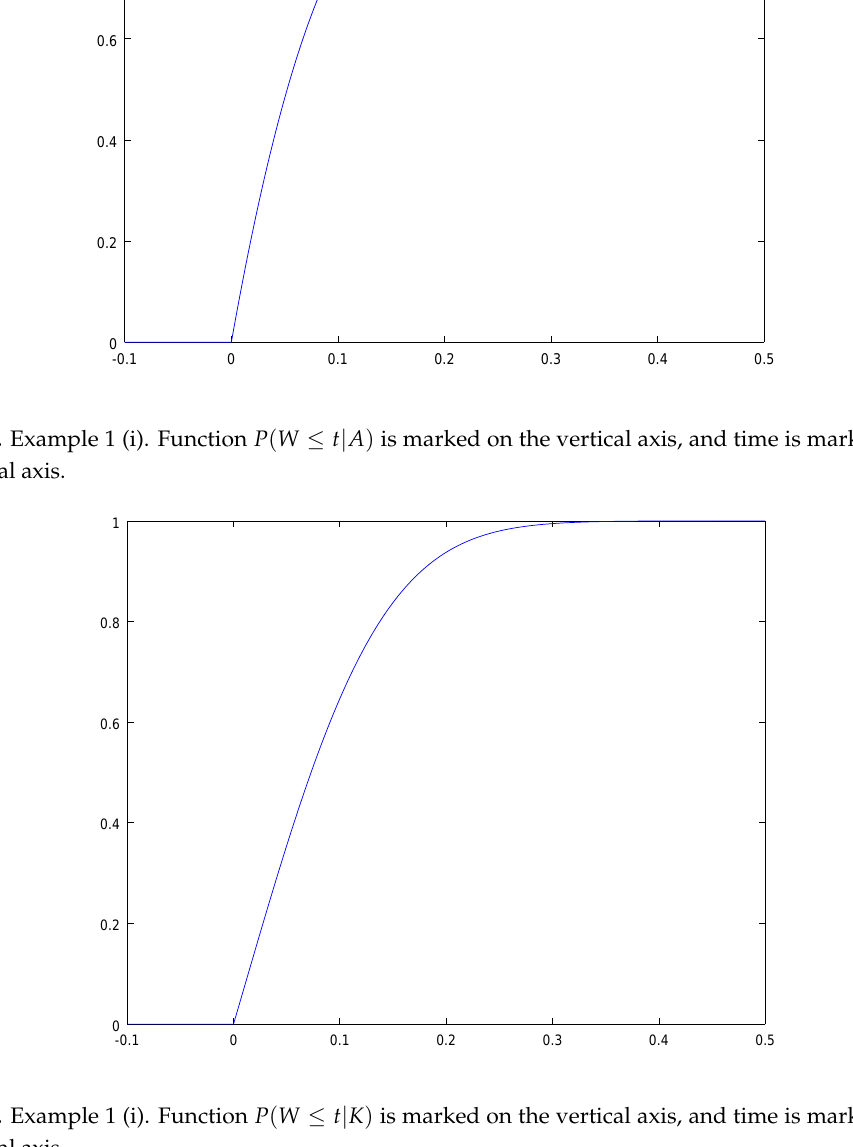
Figure 3. Example 1 (i). Function P ( W ≤ t | K ) is marked on the vertical axis, and time is marked on the horizontal